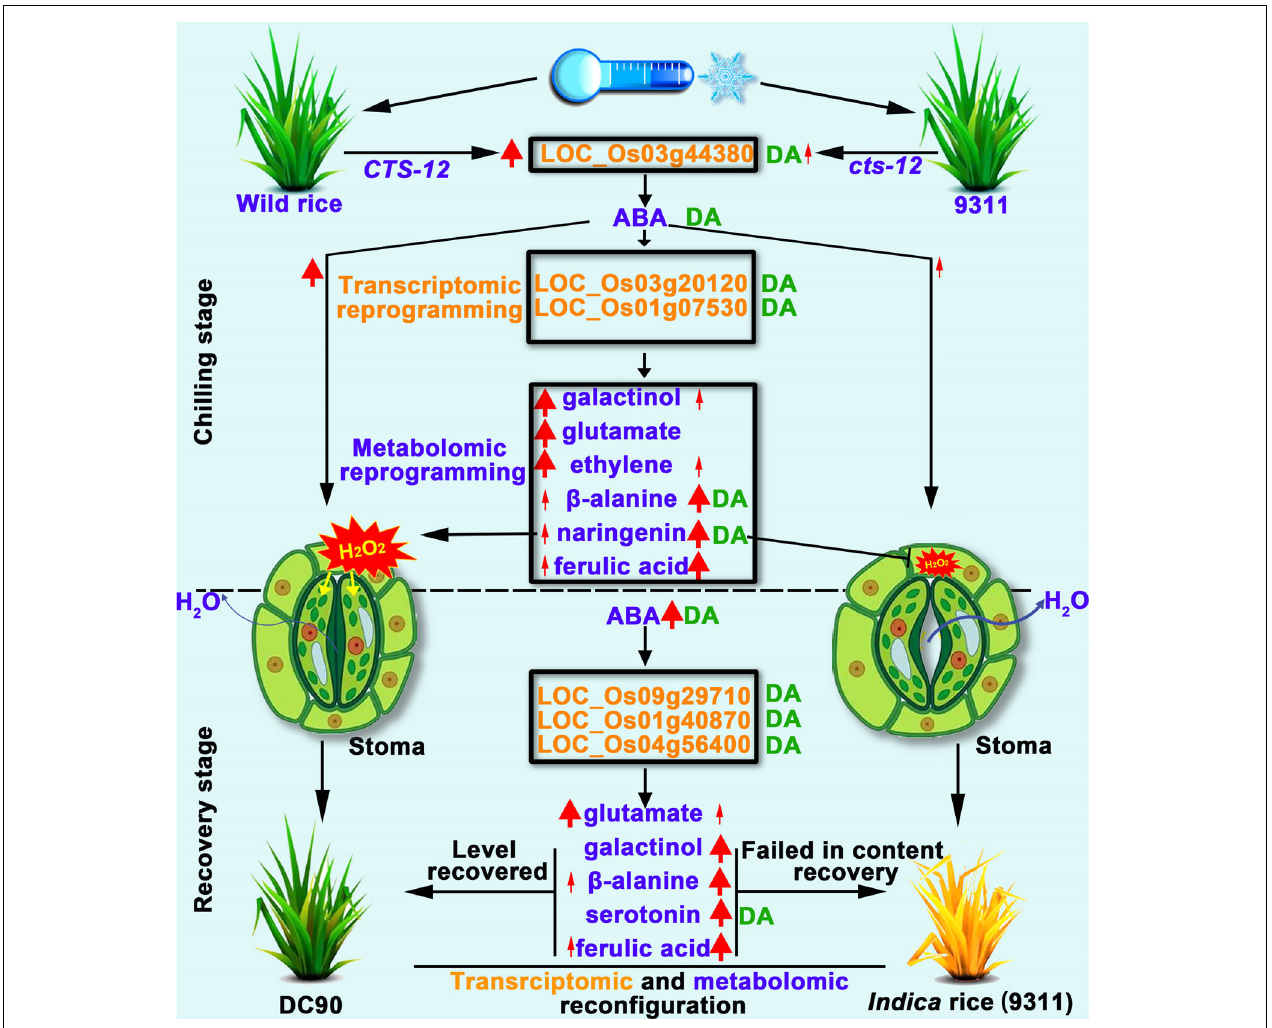
FIGURE 9 | Working model proposed to depict the impact of CTS-12 on the reprogramming of transcriptomic and metabolomic profiles in response to chilling stress. Thin and thick red arrows represent weak and strong inductions in response to chilling stress, respectively. Thin and thick dark blue arrows indicate lower and higher water loss from stomata under chilling stress, respectively. The green letters DA to the right of transcripts or metabolites represent discriminatory DEGs or DAMs identified by OPLS-DA